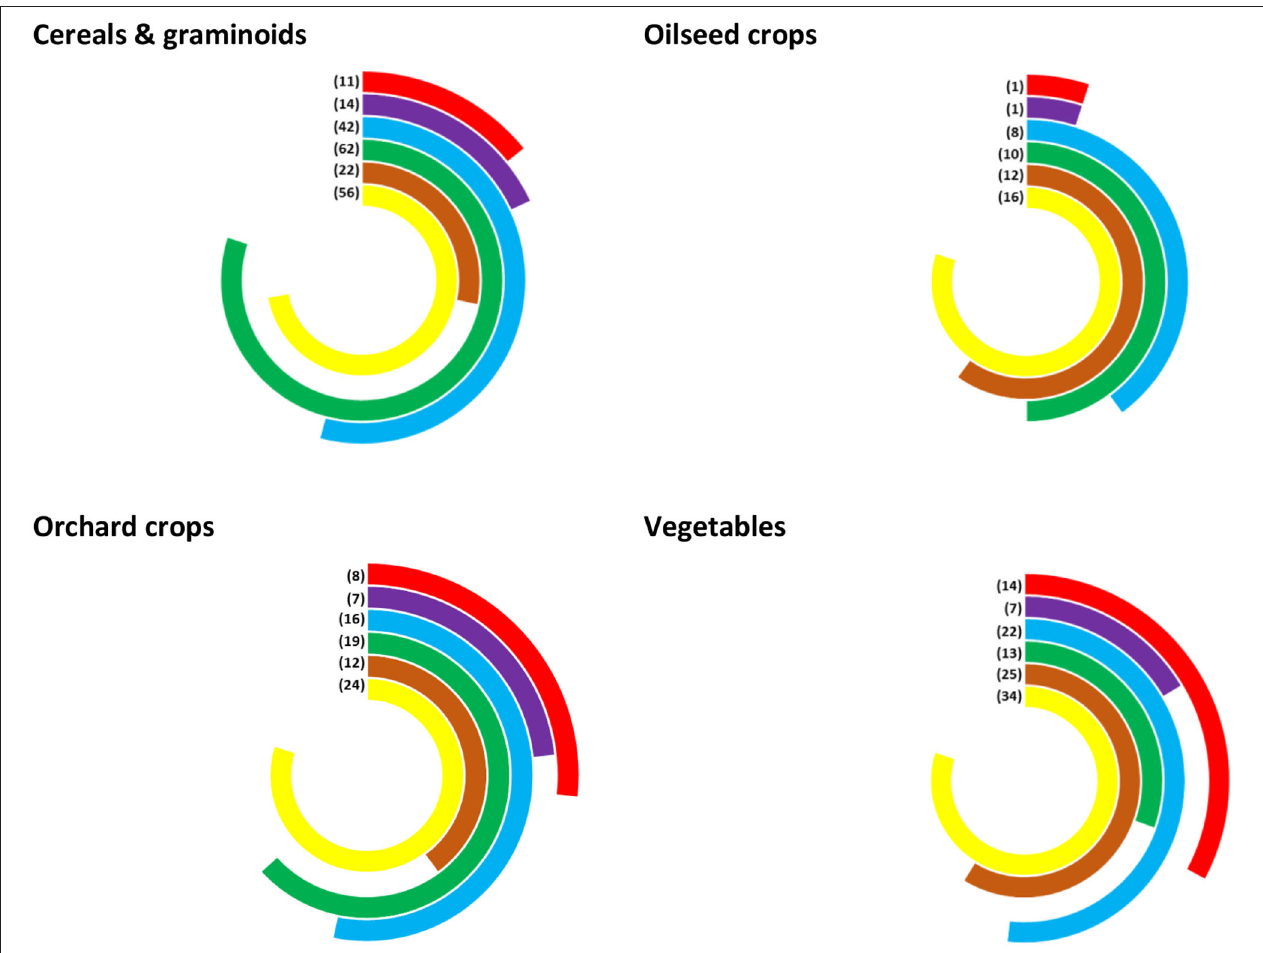
FIGURE 5 | Commodity-specific progress of biological control science along a 6-step, outcome-oriented “impact pathway.” Within the concentric donut chart, the exact number of scientific publications covering a given theme is indicated next to the respective loop. Patterns are plotted for all five Asian countries, over a 50-year time frame. The category of “cereals and graminoids” includes rice, while “oilseed crops” covers coconut, oil palm, and soybean. Crop classifications are based on the United Nations Food and Agriculture Organization, UN-FAO.